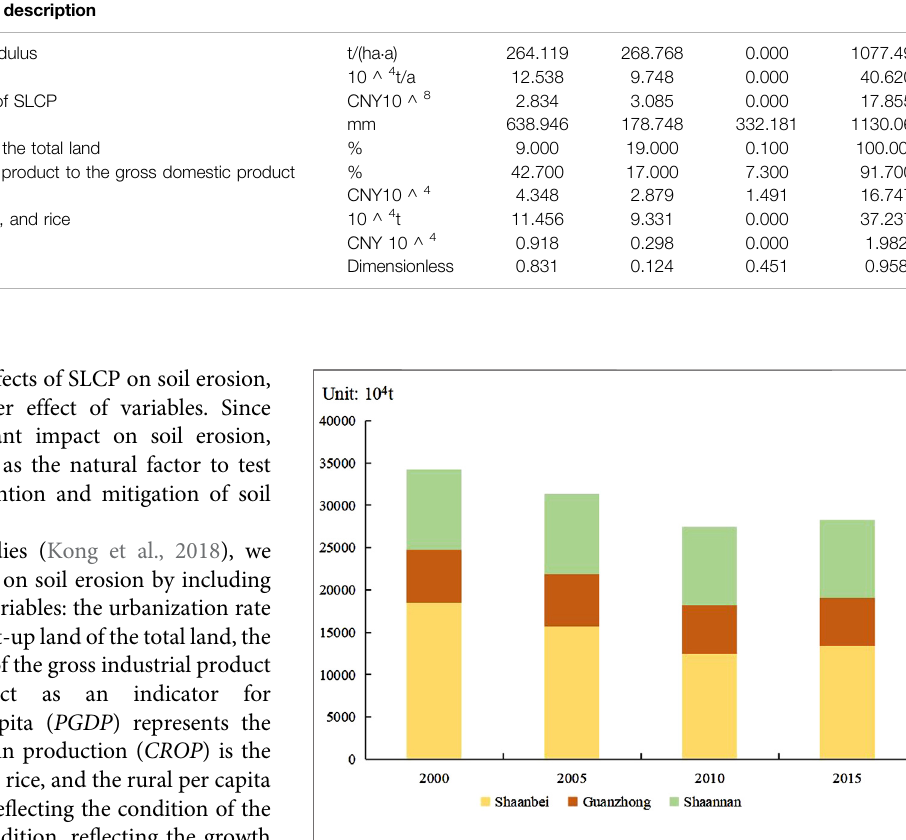
FIGURE 3 | Total soil erosion in sub-regions of Shaanxi Province, 2000 –